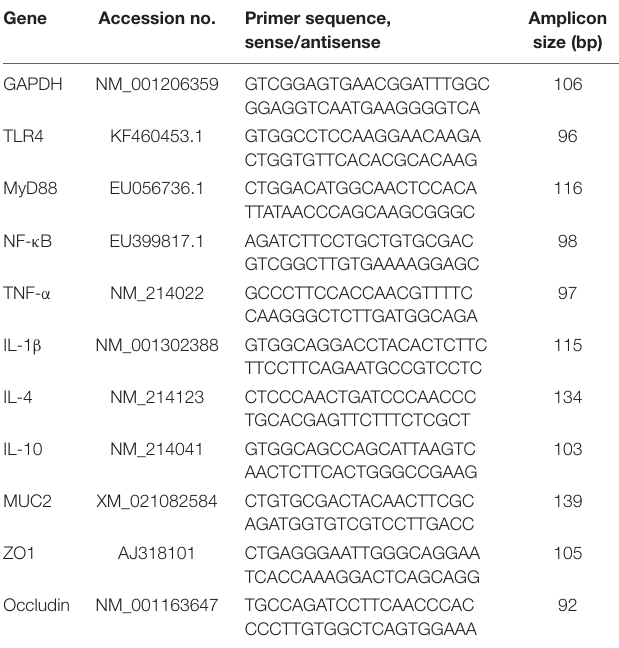
TABLE 2 | Primer sequences used in quantitative real time PCR